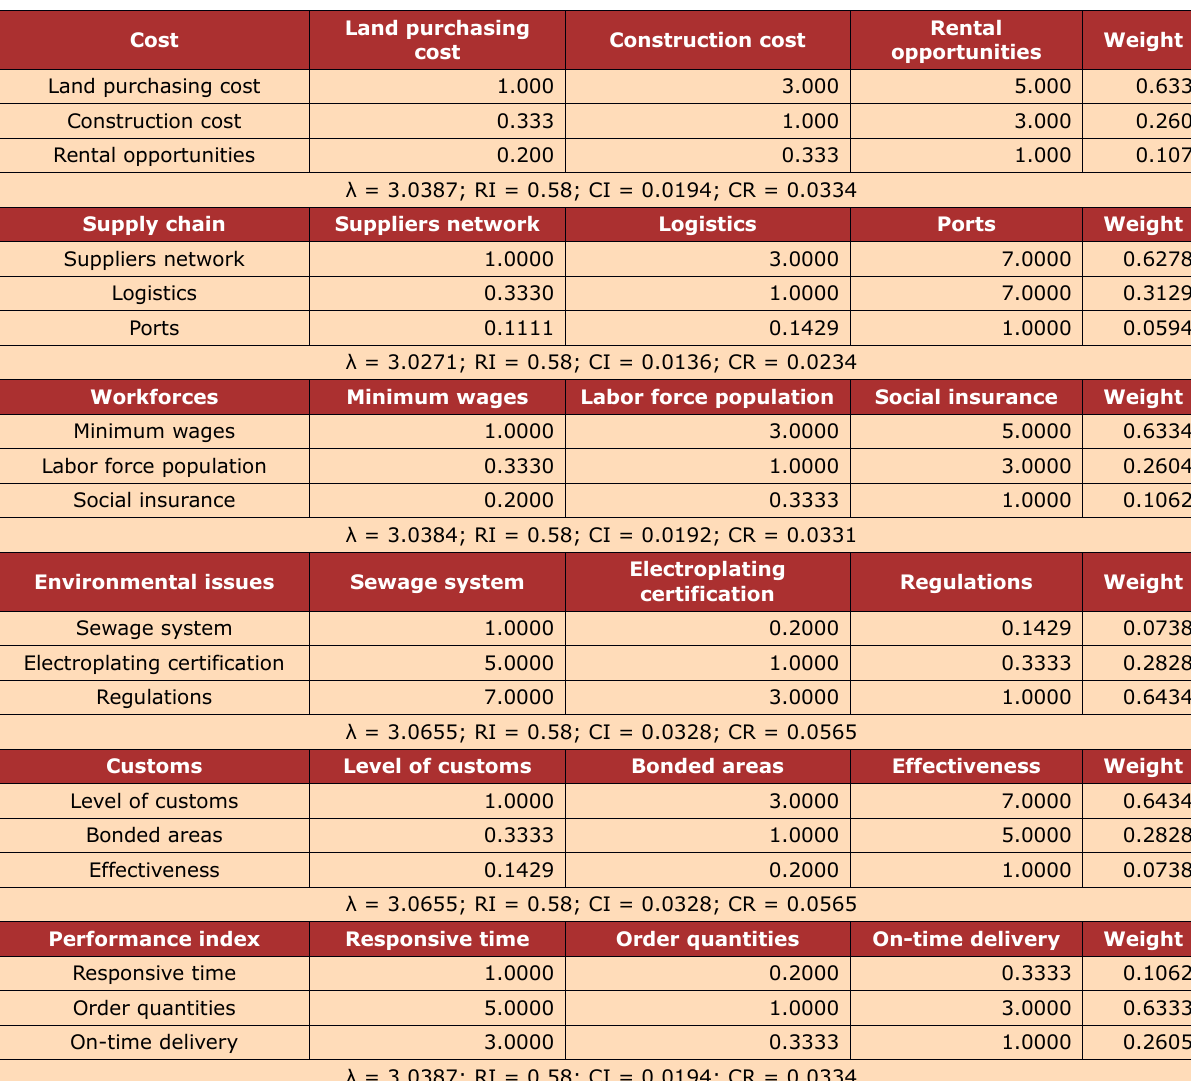
Table 3. Pair-wise comparison matrix of